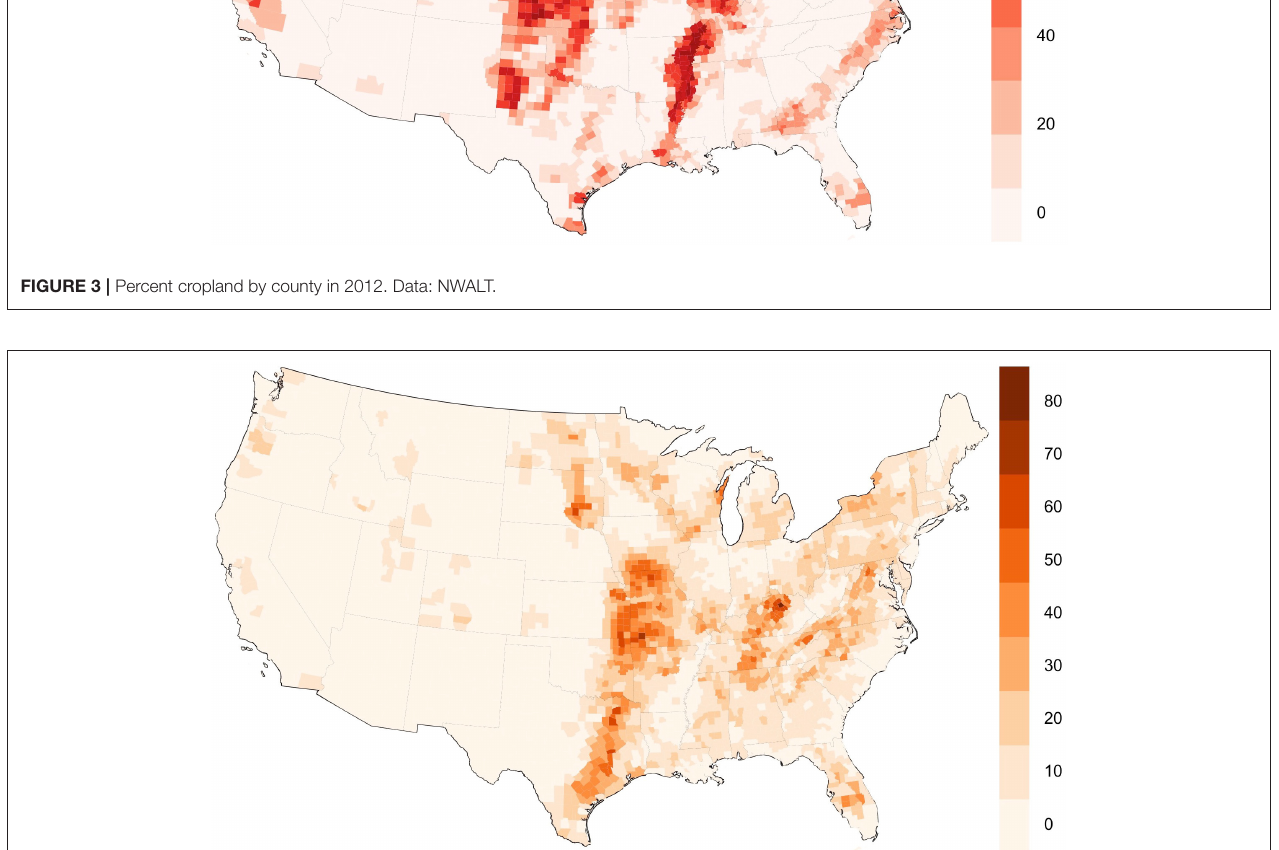
FIGURE 4 | Percent pasture and hay land by county in 2012. Data: